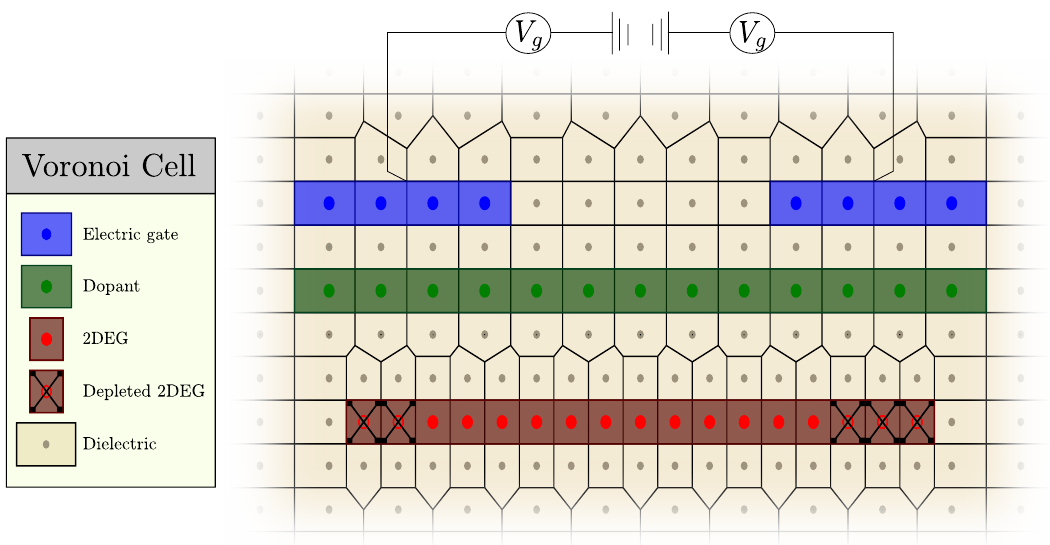
Figure 7: Sketch of the discretized Poisson problem for the geometry of Fig. 1(b). The 2DEG and depleted 2DEG voronoi cells belong to the sites in respectively. The dopant and dielectric voronoi cells correspond to Neumann sites, ⊂ i.e. belong to . The cells forming the electric gate belong to N P